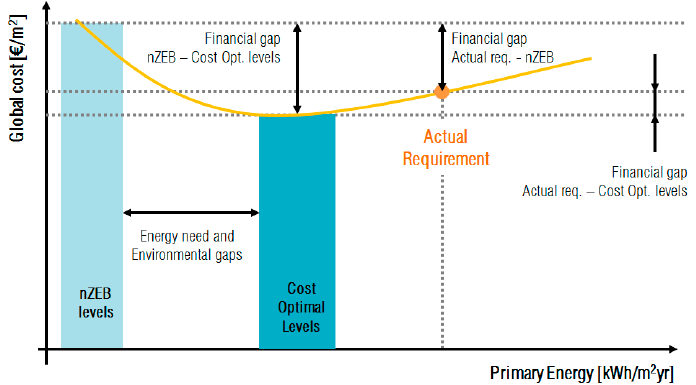
Figure 3. Energy, environmental, and financial gaps in cost-optimal calculations.